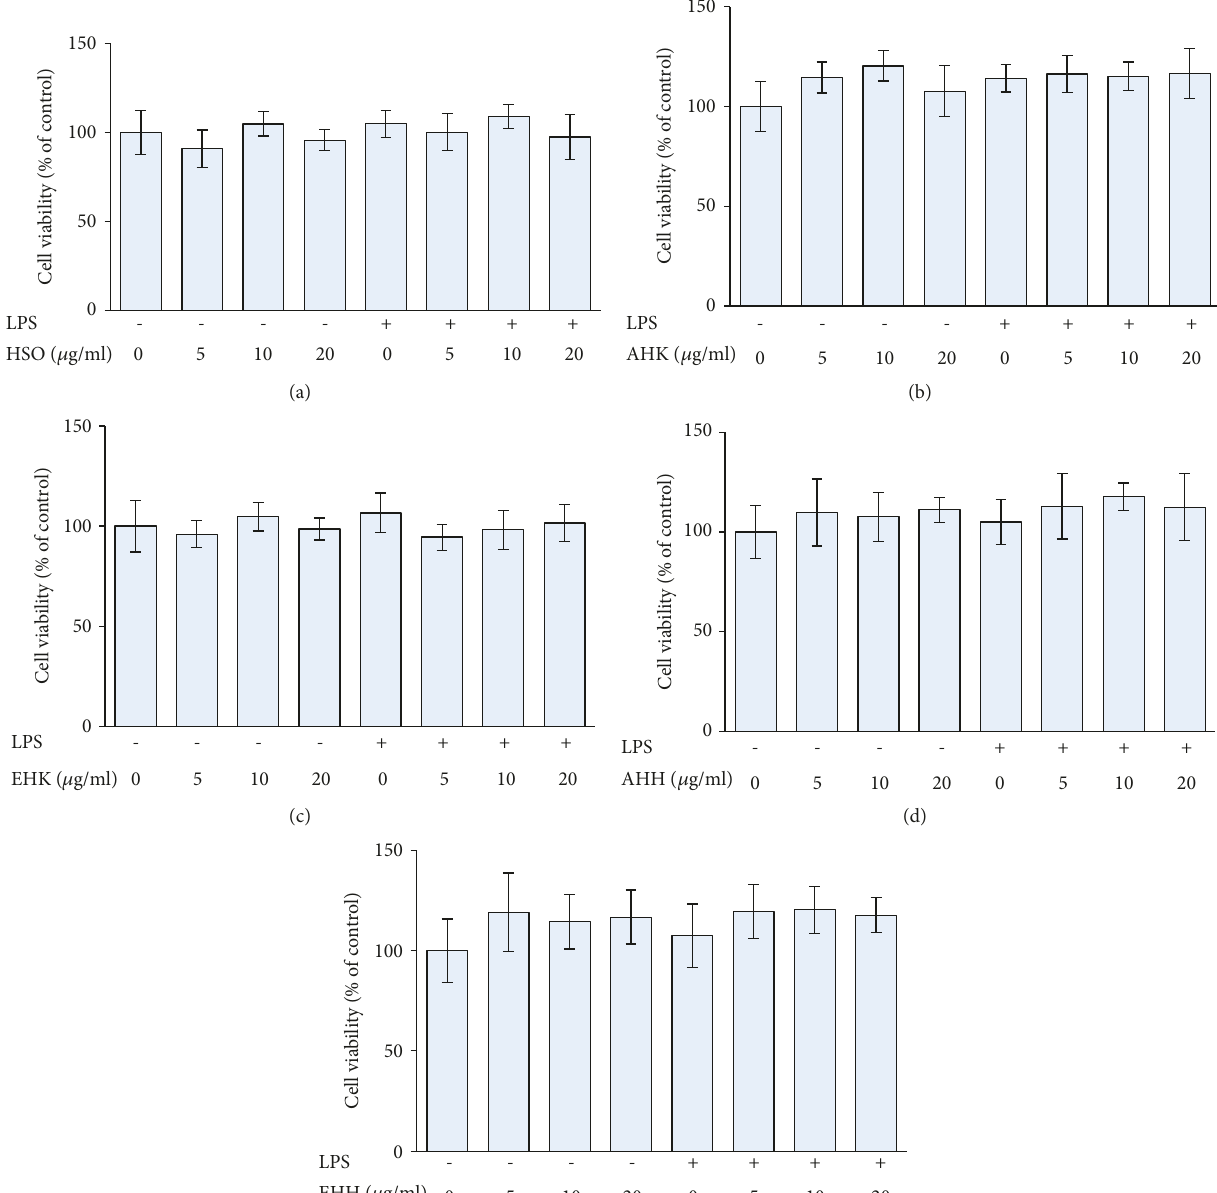
Figure 1: The effect of HSO (a), AHK (b), EHK (c), AHH (d), and EHH (e) on PBMC proliferation. PBMCs were separated using Ficoll-Paque density centrifugation, seeded in 96-well plates and treated with 10 𝜇 g/ml LPS and extracts at the indicated concentrations. The cells were then incubated for 24 h before the addition of WST-1 cell proliferation assay reagent.